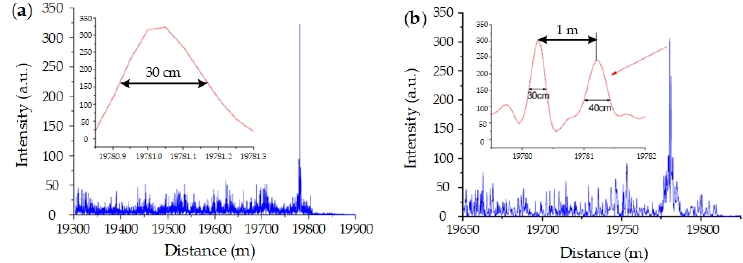
Figure 14. Experimental results with ( a ) one PZT and ( b ) two PZTs. Reproduced with permission